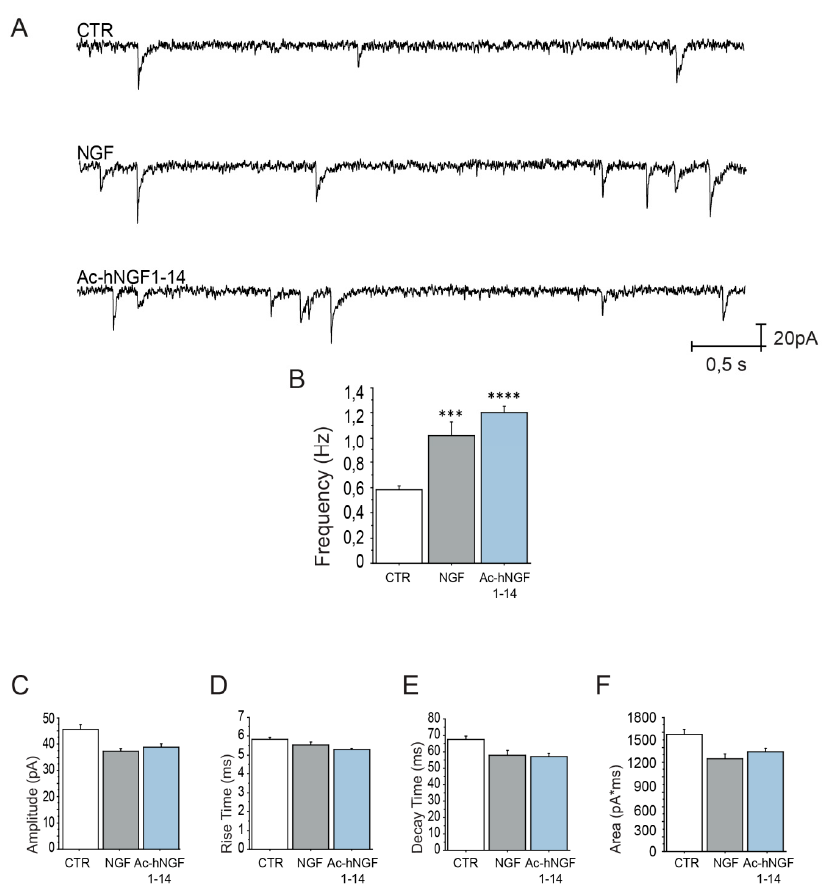
Figure 5. Ac-hNGF1–14 potentiates the spontaneous excitatory neurotransmission of cholinergic neurons in a NGF-like manner. ( A ) Representative traces of mEPSCs (0.5 s, 20 pA) recorded from cholinergic neurons cultures at 10 DIV in control conditions and following 30 min treatment (37 °C) with NGF (100 ng/mL; 3.84 nM) and Ac-hNGF1–14 peptide (10 μ M), respectively. ( B – F ) Bar plots reporting the mean ±SEM frequency ( B ), amplitude ( C ), rise time ( D ), decay time ( E ) and area ( F ) of the mEPSCs recorded in the three experimental conditions. Neurons incubated with NGF (NGF1.08 ± 0.1 Hz; *** p < 0.001) and Ac-hNGF1–14 peptide (1.2 ± 0.01 Hz; **** p < 0.0001) show a mEPSC frequency significantly higher than control neurons (CTR, 0.58 ± 0.05 Hz). Significant differences were not detected for the other analysed parameters, like amplitude (CTR: 45.9 + 2.84 pA; NGF: 39.1 + 2.4 pA; p = 0.18; Ac-hNGF1–14: 37.4 + 2.2 pA, p = 0.07), rise time (CTR: 5.82 + 0.2 ms; NGF: 5.21 + 0.2 ms, p = 0.24, Ac-hNGF1–14: 5.53 + 0.3 ms, p = 1.00), decay time (CTR: 67.6 + 3.12 ms; NGF: 57.22 + 3.4 ms, p = 0.18; Ac-hNGF1–14: 58.11 + 4.9 ms, p = 0.27), and area (CTR: 1576 + 119.4 ms*pA; NGF: 1337 + 87.15ms*pA; p = 0.36; Ac-hNGF1–14:1246 + 116.7ms*pA; p = 0.11), as compared to control neurons (CTR). *** p < 0.001; **** p < 0.0001. Data ( n = 19 neurons for CTR and NGF; n = 20 neurons for Ac-hNGF1–14) were from 3 di ff erent